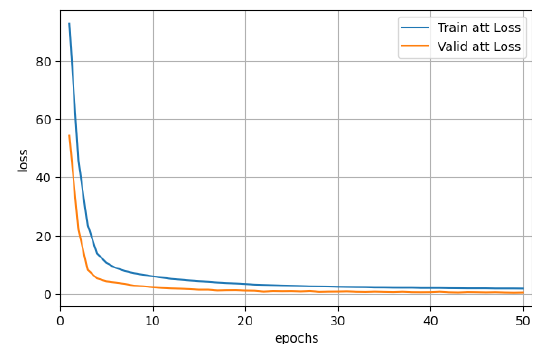
Figure 4. The loss of